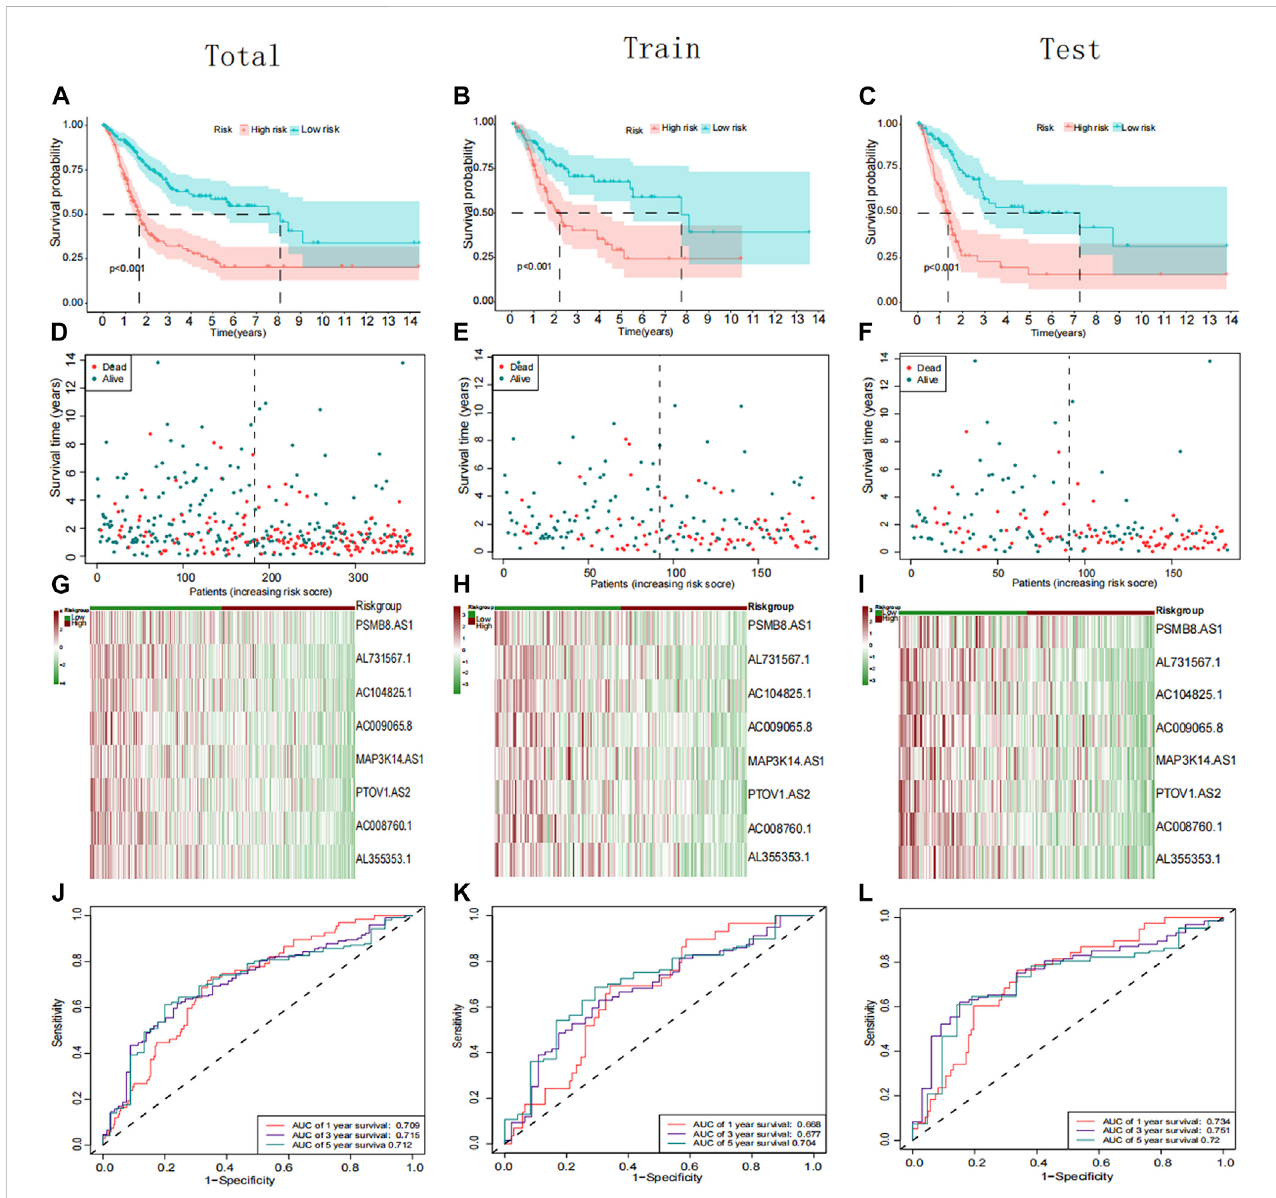
FIGURE 3 Prognostic analysis of the PRR lncRNAs signature in the total, training cohort, and testing group. (A – C) Kaplan – Meier curve of the patient in the whole, training cohort, and testing groups. (D – F) The rank of calculated risk scores in the total, training cohort, and testing groups. (G – I) Heatmap showed the differencesof8PRRlncRNAsinthewhole,trainingcohort,andtestinggroups. (J – L) Time-independentreceiveroperatingcharacteristic(ROC)analysisinthe total, training cohort, and testing